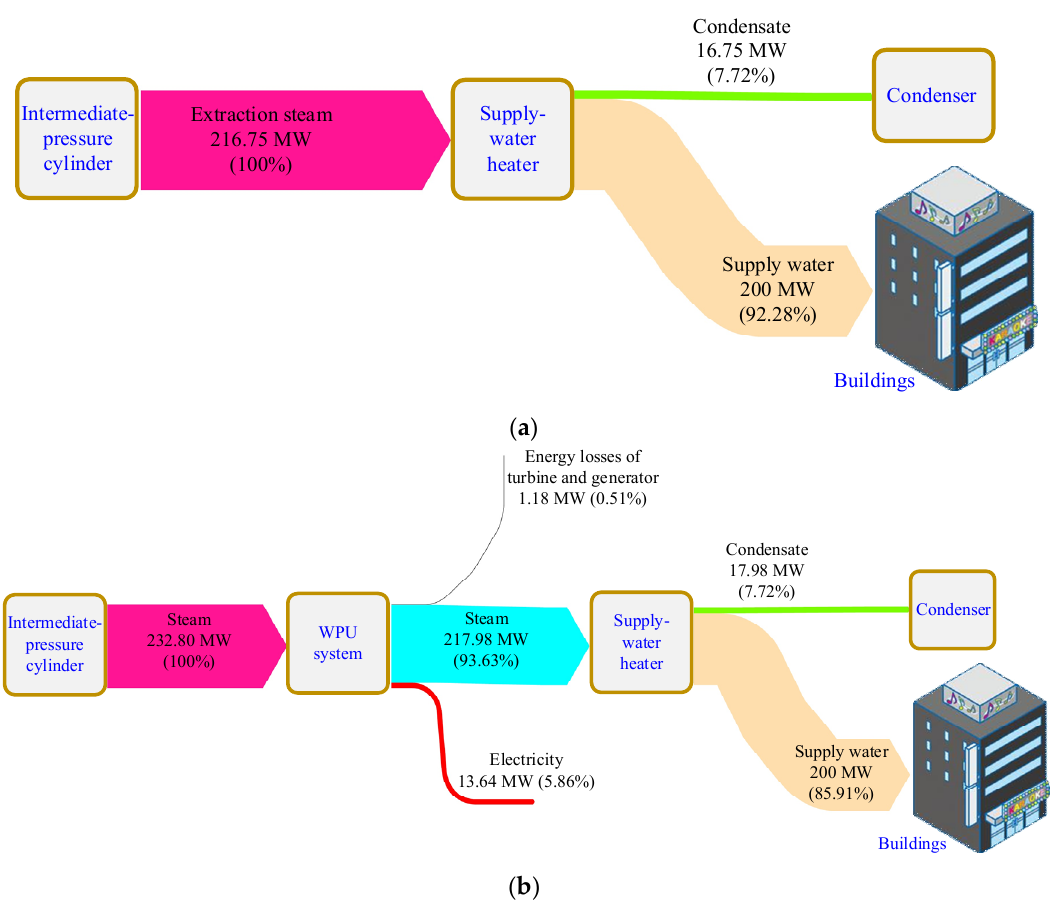
Figure 6. Energy flow diagrams of the original and proposed heating processes. ( a ) Original heating process; ( b ) proposed heating process.